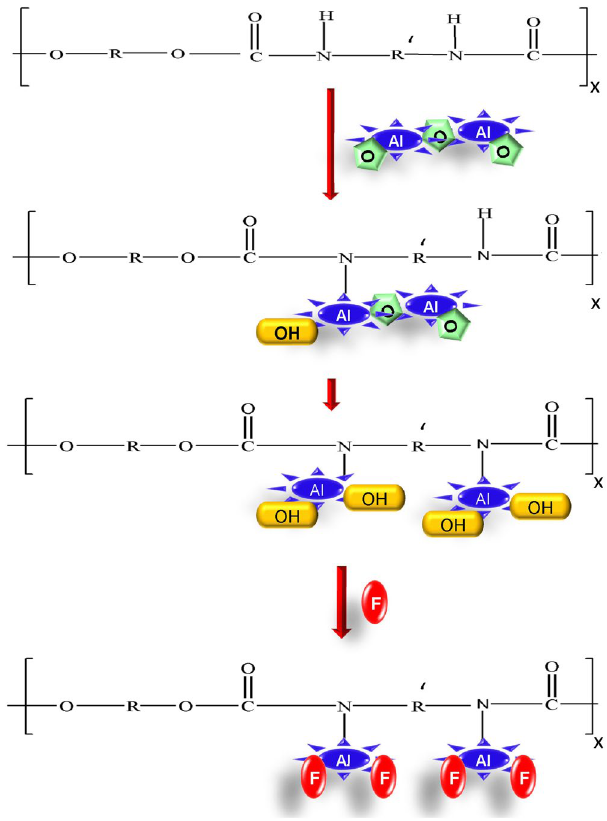
Figure 6. Proposed mechanism for the NPs impregnation on PUF and adsorption of F on NPs.